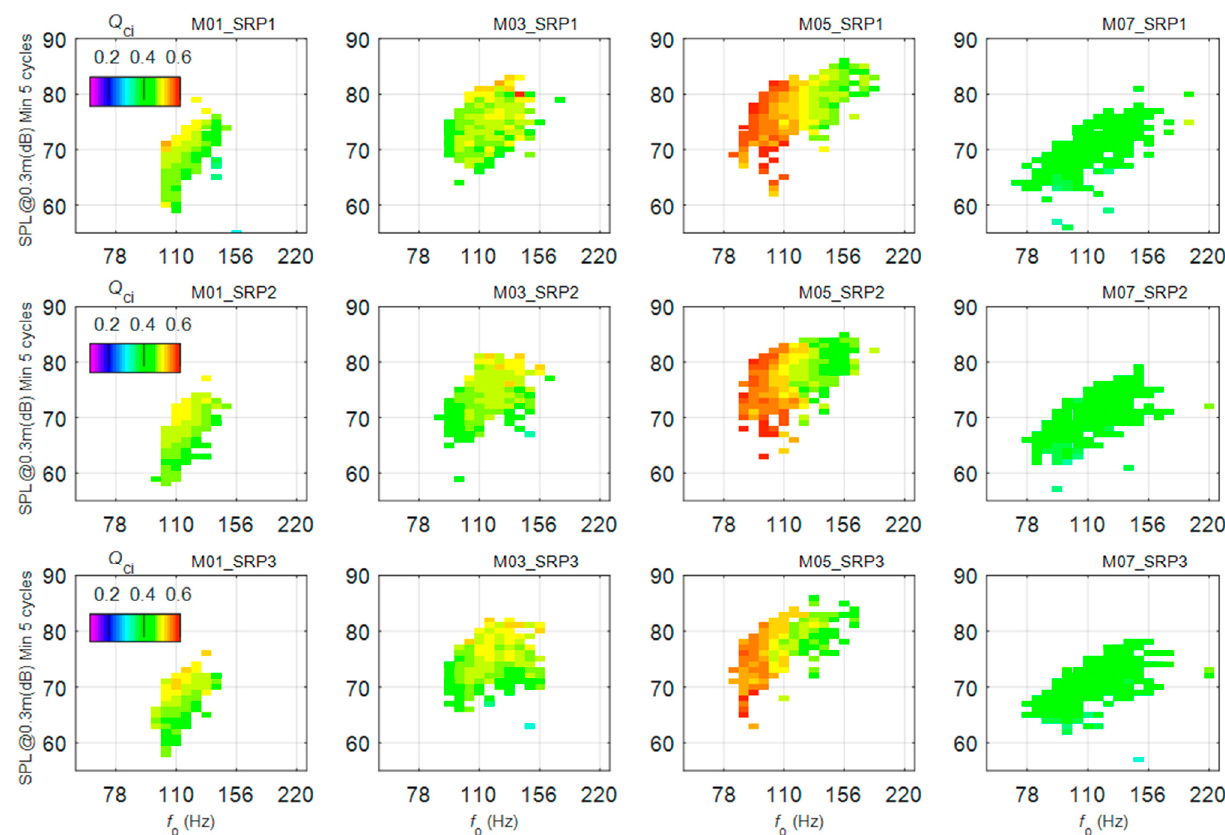
Figure 2. Voice maps of a given task tend to be similar within persons, but can be very different from one individual to another. As an example, these maps illustrate the variation with SPL, f o , and individual in the EGG quotient of contact by integration Q ci [15], over the habitual speech range. Four vocally healthy adult males (columns) performed three consecutive readings (rows) of the full Rainbow Passage . Each map results from about two minutes of reading, in a quiet recording booth. The Q ci was measured for every phonatory cycle above a regularity threshold and averaged within each cell of 1 dB and 1 semitone on the map, in real time. The per-cell average Q ci is colour-coded as in the horizontal bars (Previously unpublished data, collected for [18], where the acquisition is described in detail.).